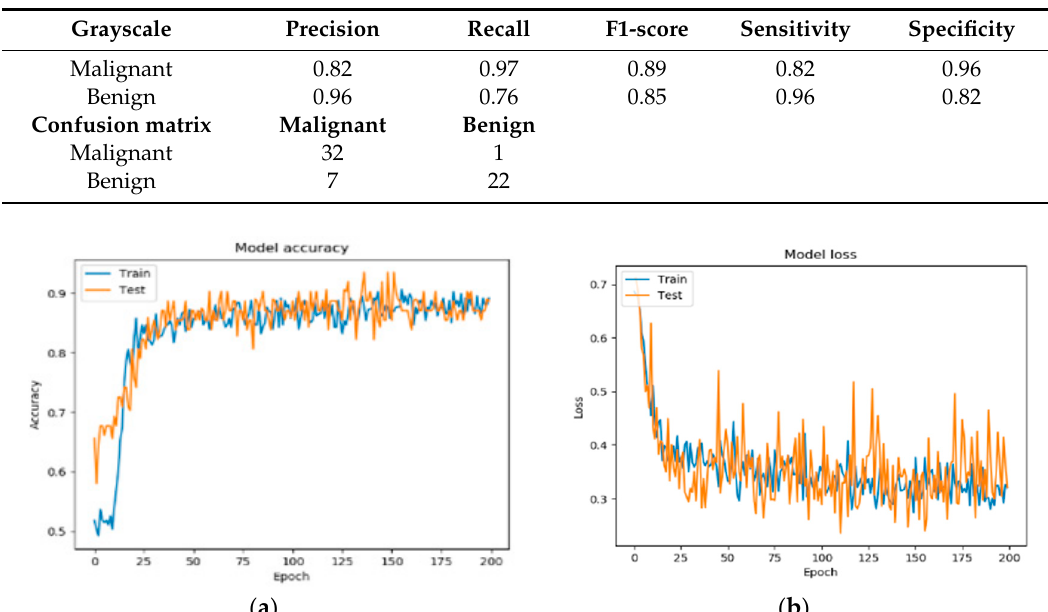
Figure 6. Precision curves for best CNN in grayscale mode: ( a ) accuracy and ( b ) loss.